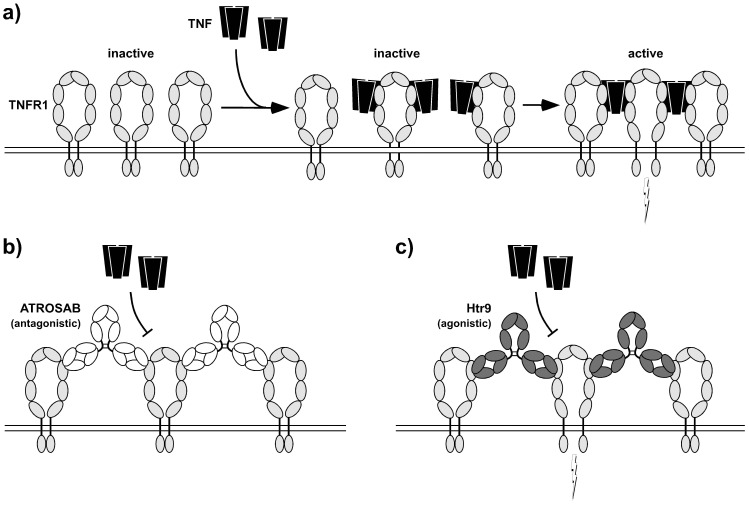
A model for TNF-TNFR1 interaction, activation and inhibition.a) Proposed model of binding of TNF to TNFR1 and formation of signaling complexes. Binding of TNF to two or more TNF receptors leads to a conformational change and activation of signal transduction [56]. b) ATROSAB binding to TNFR1 results in formation of receptor-antibody complexes, however, does not lead to a conformational change in the receptor. c) Binding of agonistic antibody Htr-9 mimics activation by TNF leading to a conformational change of the receptor.